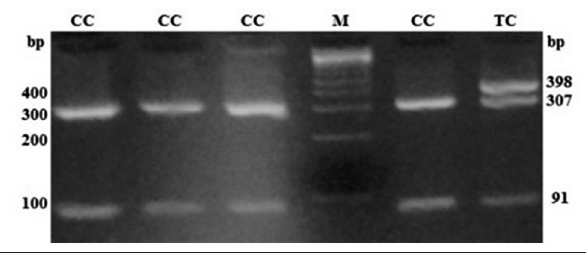
Figure-5: Polymerase chain reaction-restriction fragment length polymorphism profile